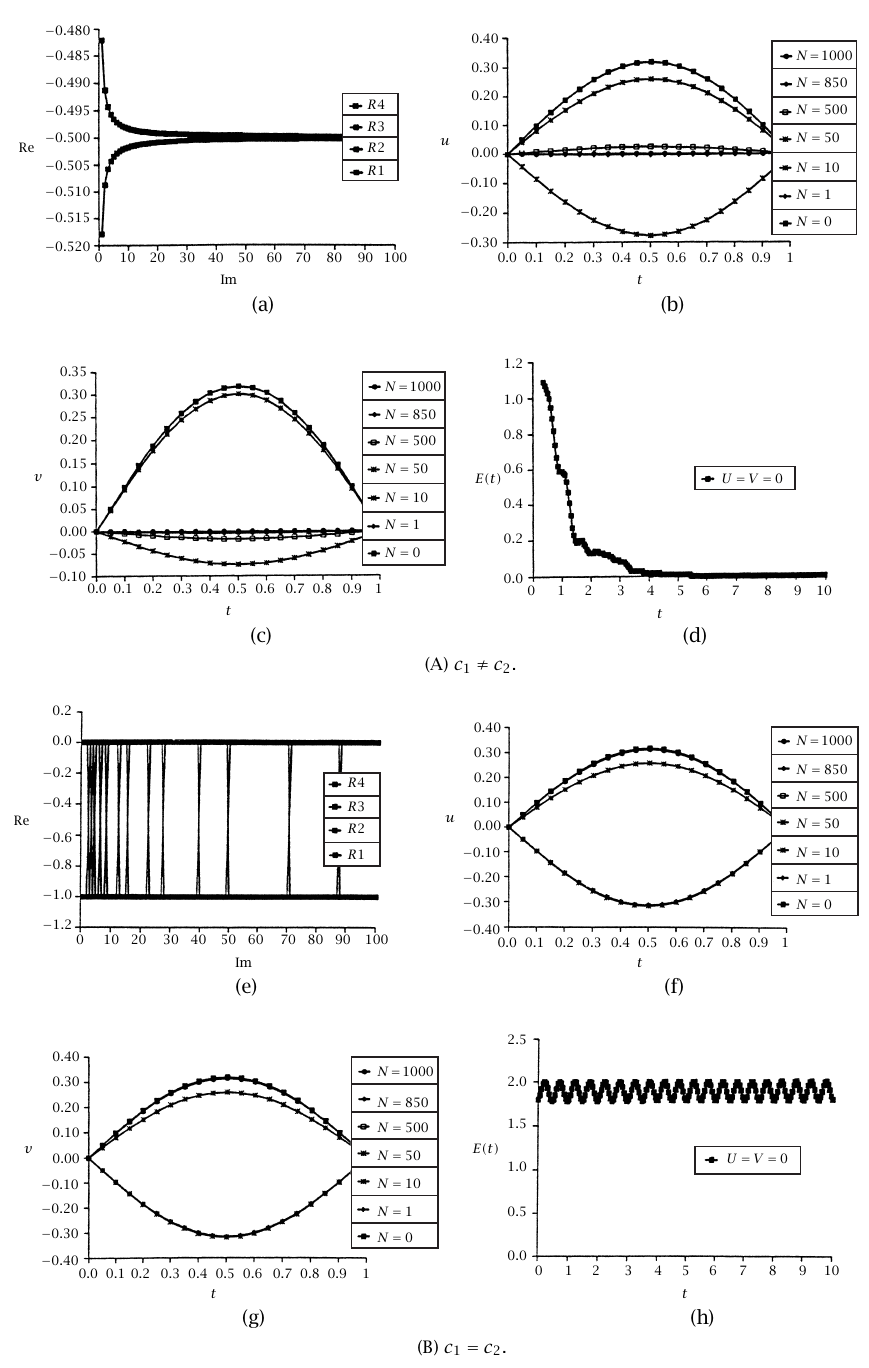
Figure 5.1 . Numerical solutions to the system (1.1) with Dirichlet boundary conditions